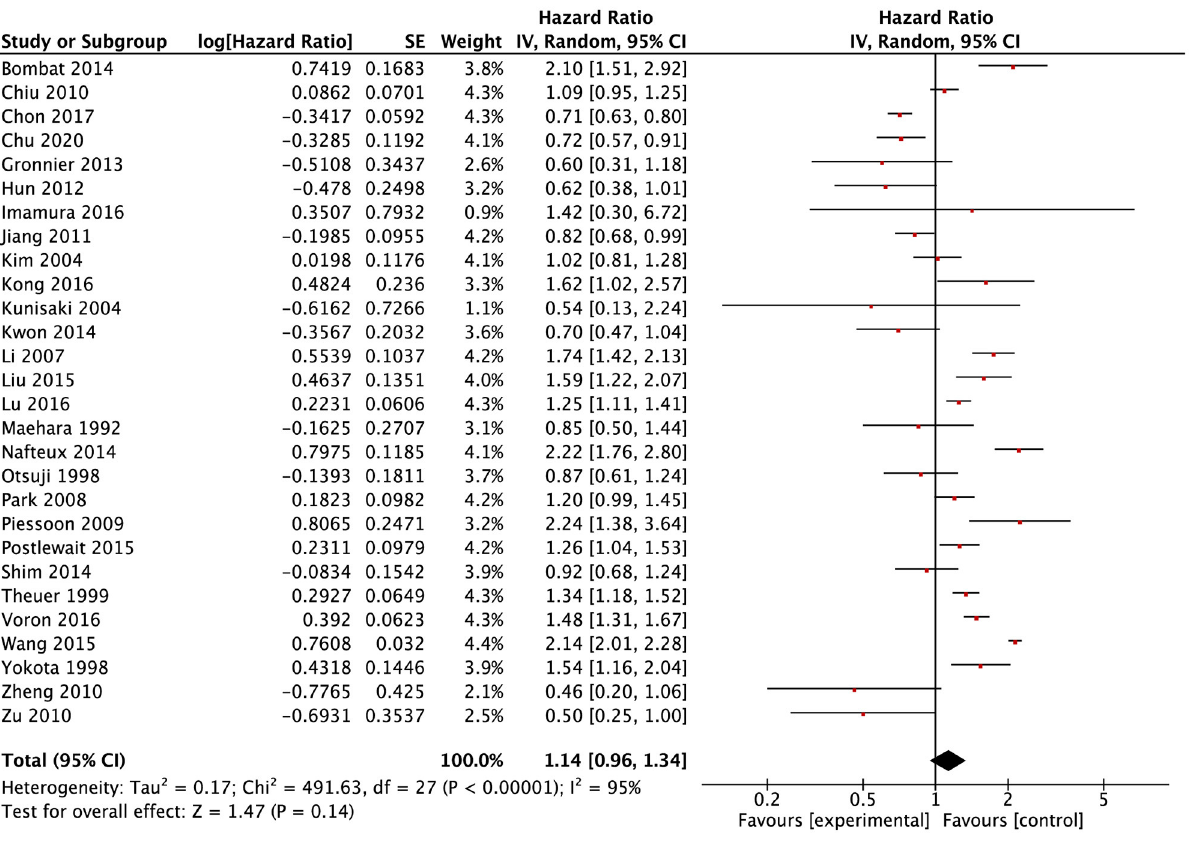
FIGURE 2 | Forest plots showing the results of meta-analysis compared between SRCC patients and NSRCC